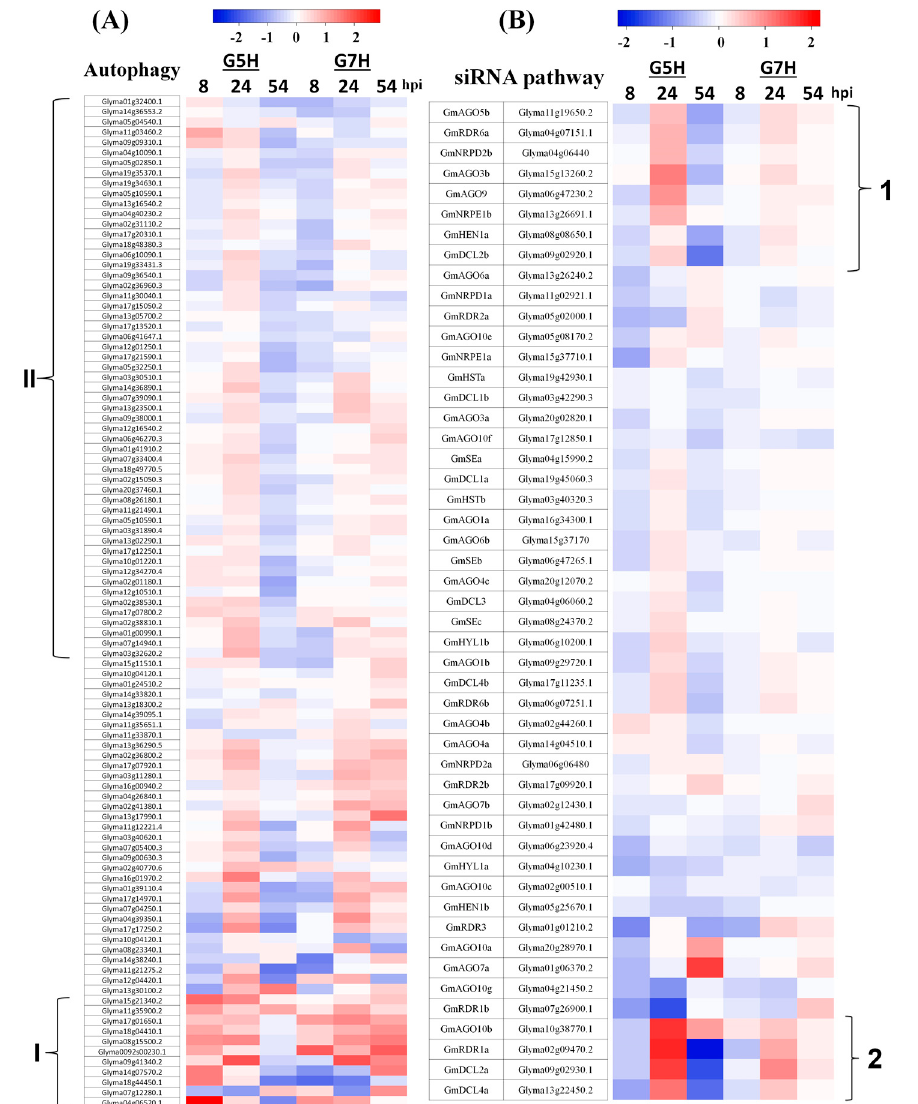
Figure 5. Heatmaps of genes involved in autophagy and siRNA pathways. Heatmaps for genes involved in authophagy ( A ) and the siRNA pathway ( B ) were generated as described in Figure 3